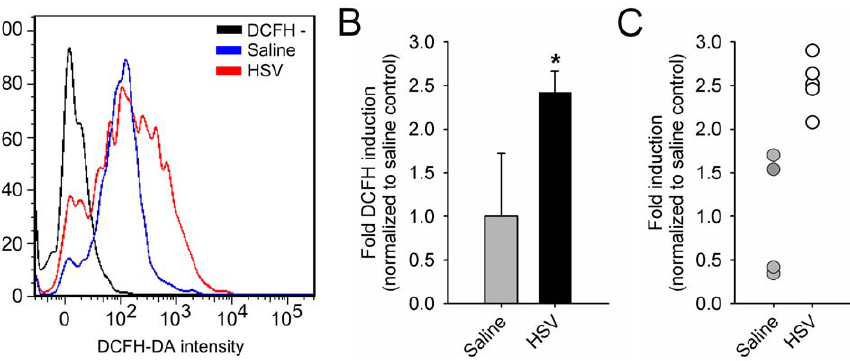
Figure 1. Increased brain ROS levels during herpes encephalitis. Balb/c mice were infected intranasally with 2 6 10 5 PFU of HSV-1 strain 17 syn + (n=10). An equal volume of saline was delivered to control mice (n=8). At 7 d p.i. whole brains were pooled, mononuclear cells were isolated and analyzed via flow cytometry using fluorescent-conjugated antibodies, CD11b-APC and CD45-APC-Cy7. CD11b + , CD45 hi macrophages/neutrophils were gated for further analysis of intracellular ROS via detection of DCFH-DA (20 m M). A ) DCFH-DA fluorescence spectrum in CD11b + , CD45 hi cells from saline (blue) and HSV-infected (red) mice. Non-DCFH-loaded control is black. Composite ( B ) and individual ( C ) ROS data are presented as fold induction of HSV-infected mice (n=5) over controls (n=5). *p ,